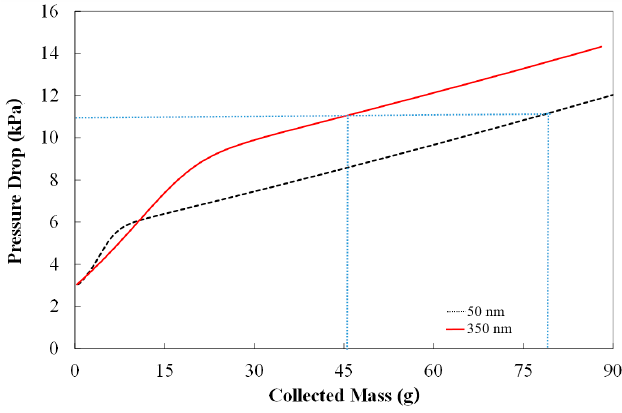
Figure 14. Pressure drop versus trapped mass for particles.